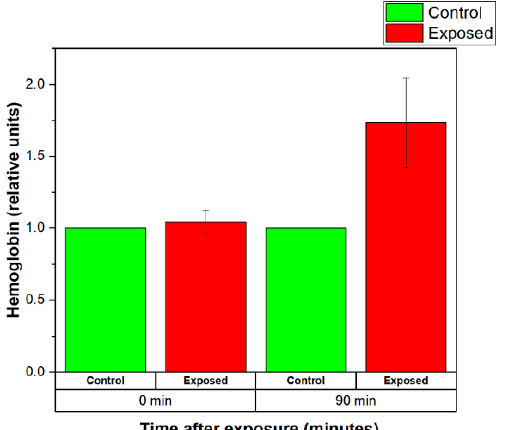
Figure 9. Normalized levels of the hemoglobin released by the control (sham-exposed) and exposed erythrocyte suspensions for 120 min to 2.41 GHz (WSA SAR = 0.4149 W/kg, psSAR1g = 0.5758 W/kg, wearable antenna input power 6.3 mW, Zigbee-like signal). The mean of 7 experiments ± SEM is shown.